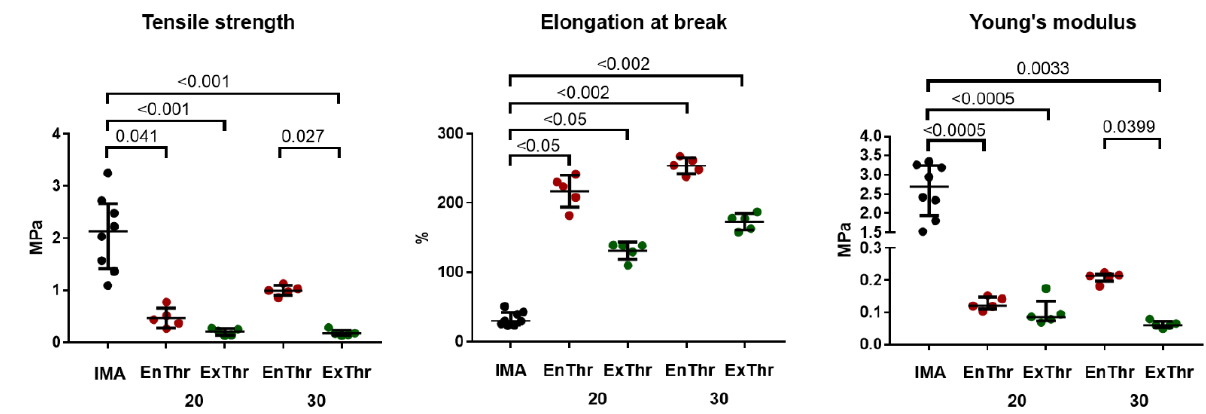
Figure 2. Mechanical properties of the fibrin matrices prepared at fibrinogen concentrations of 20 and 30 mg/mL using endogenous (EnThr) and exogenous (ExThr) thrombin as compared to the internal mammary artery (IMA). Center lines indicate the median, whiskers indicate the 25th and 75th percentiles.